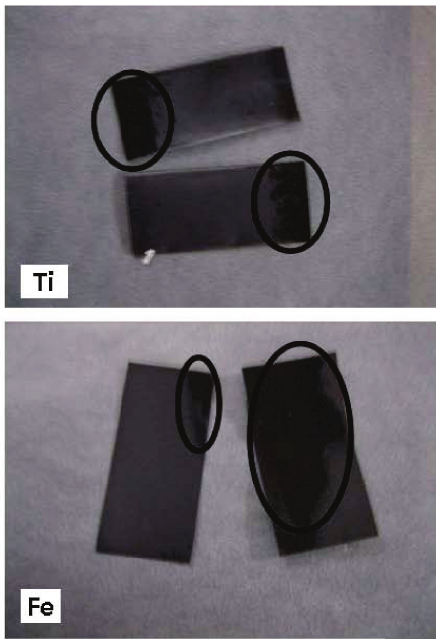
Figure 2. Photographs of titanium and iron catalyst after the atomization – pyrolysis treatment at 973 K for 5 hours. The colour of metal surface changed to black in the encir- cled area.